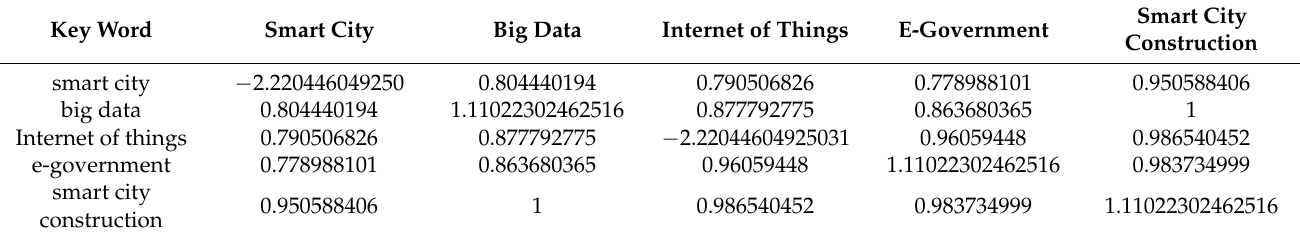
Table 2. High-frequency keyword dissimilarity matrix